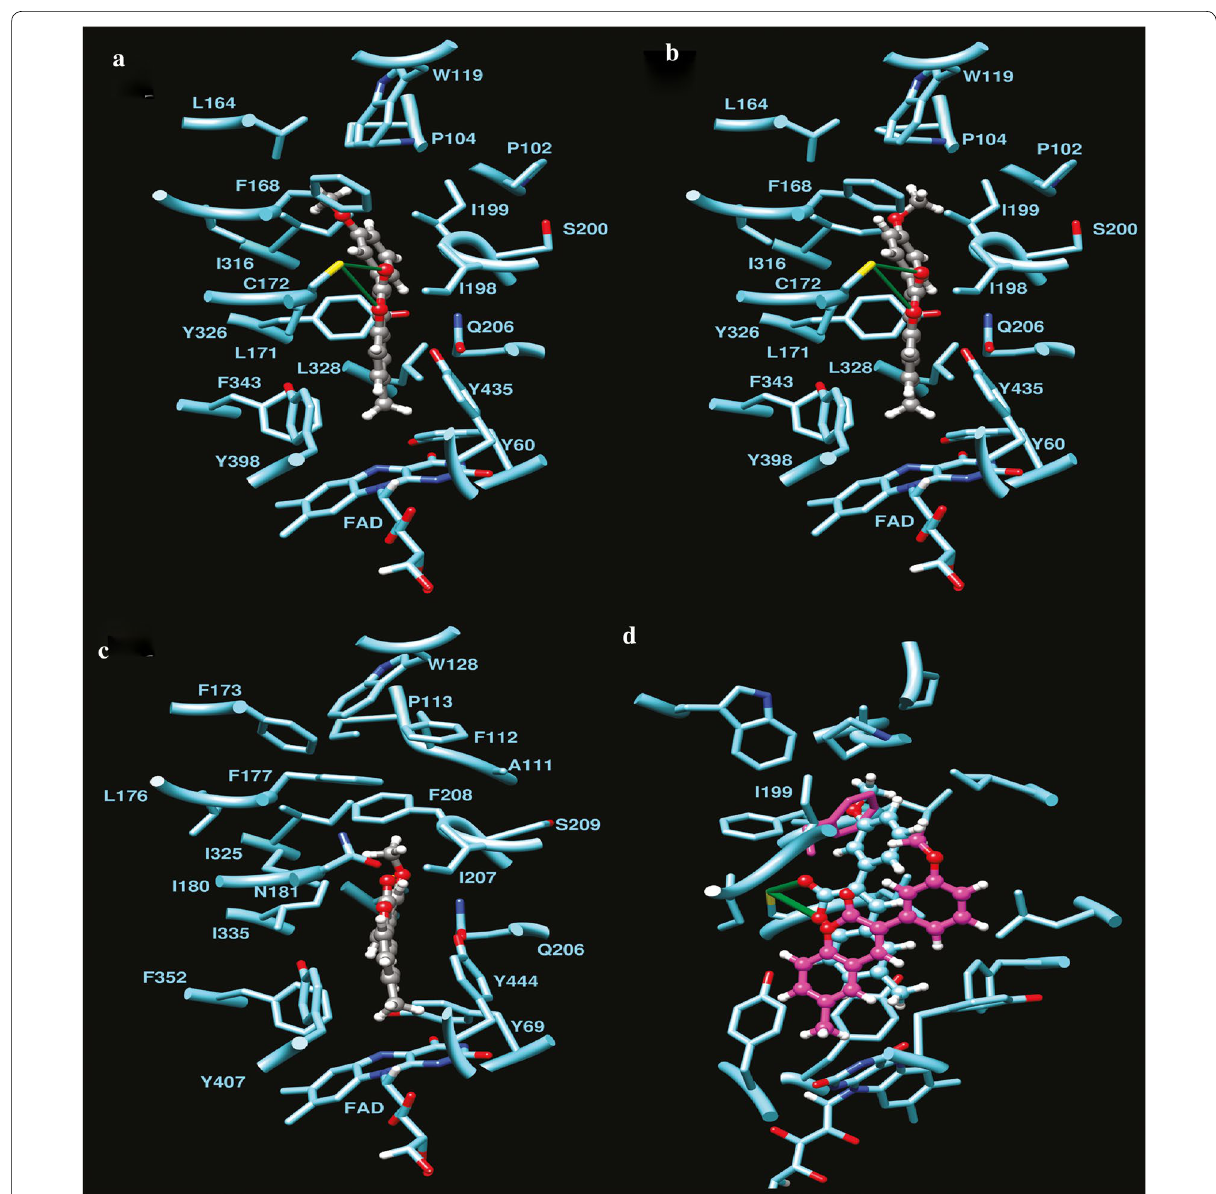
Fig. 64 Molecular docking studies of coumarin derivatives C73 and C63 . Most stable binding poses of compound C63 ( a ) and C73 ( b ) into MAO-B binding site, and compound C63 ( c ) into MAO-A binding site. Compounds are colored by atom type, and predicted H-bonds are represented as green pseudobonds. Superposition of binding poses of compound C63 ( d ) to both isoenzymes, MAO-A (ligand and Phe208 in magenta), and MAO-B